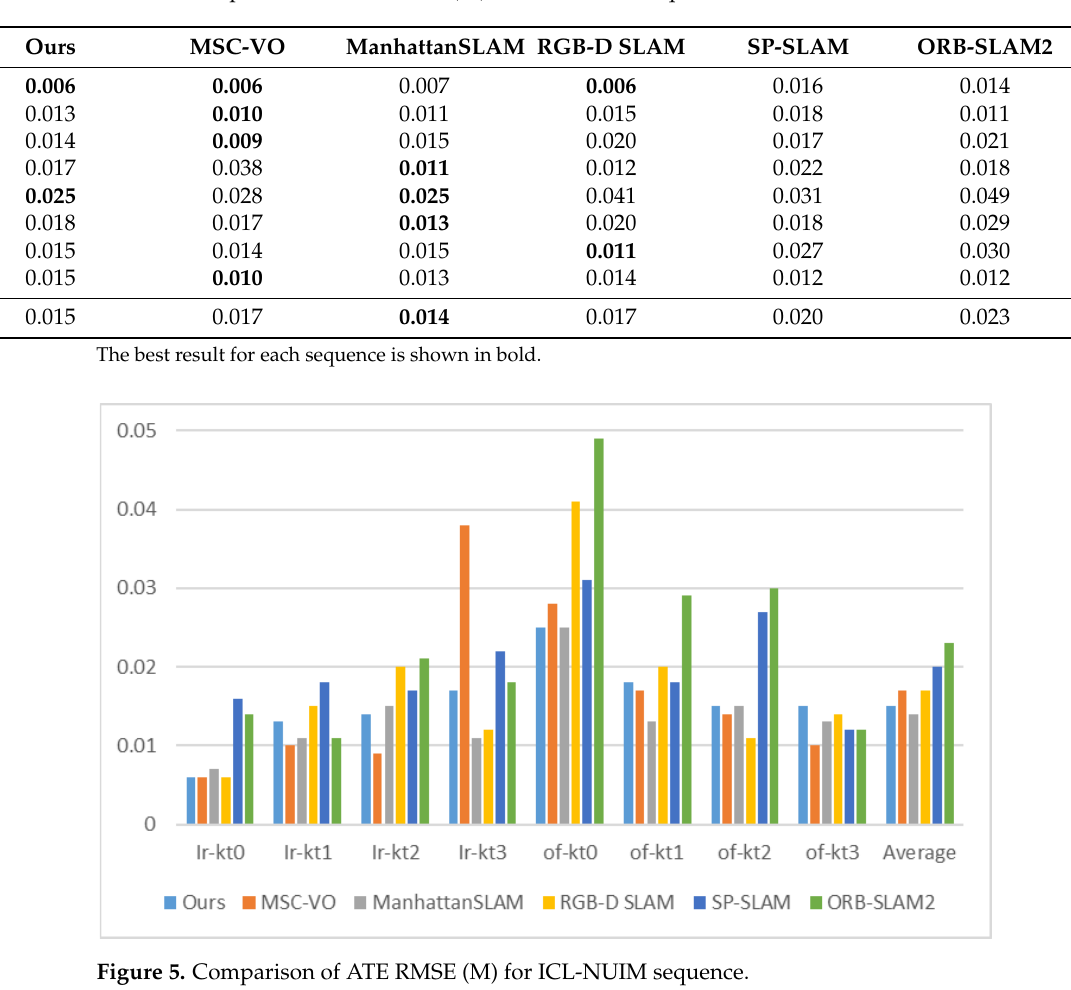
Figure 5. Comparison of ATE RMSE (M) for ICL-NUIM sequence.